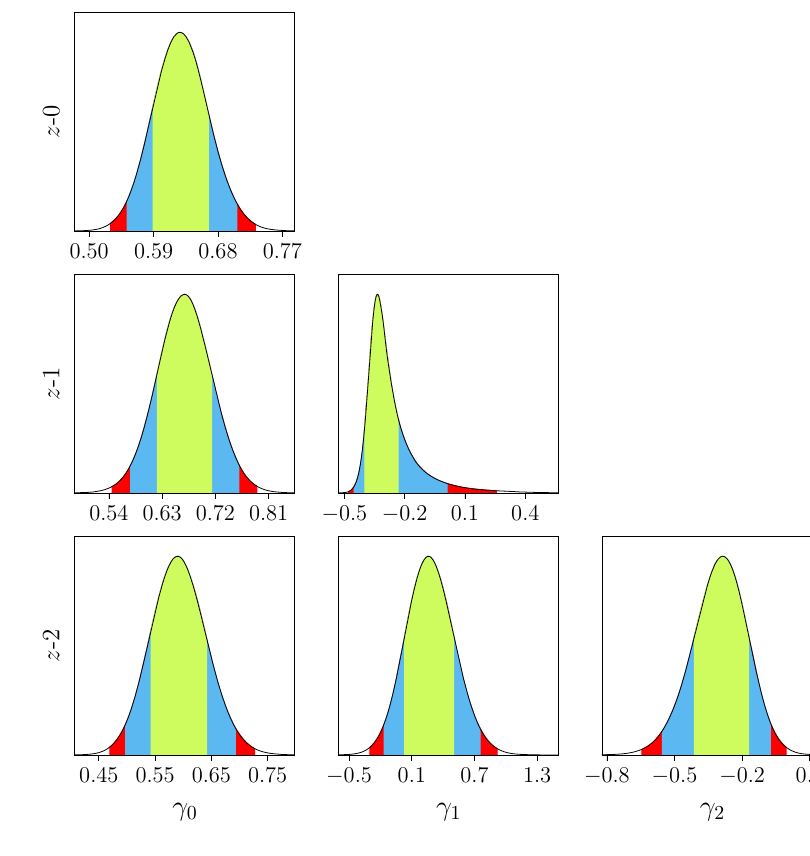
Fig. 1 The 1D marginalized probability distributions of the parameters related to γ . The 1 σ , 2 σ , 3 σ uncertainties are shown by the green, blue, red regions, respectively. The top, middle, bottom panels correspond to the z -0, z -1, z -2 cases, respectively. See the text and Table 2 for details